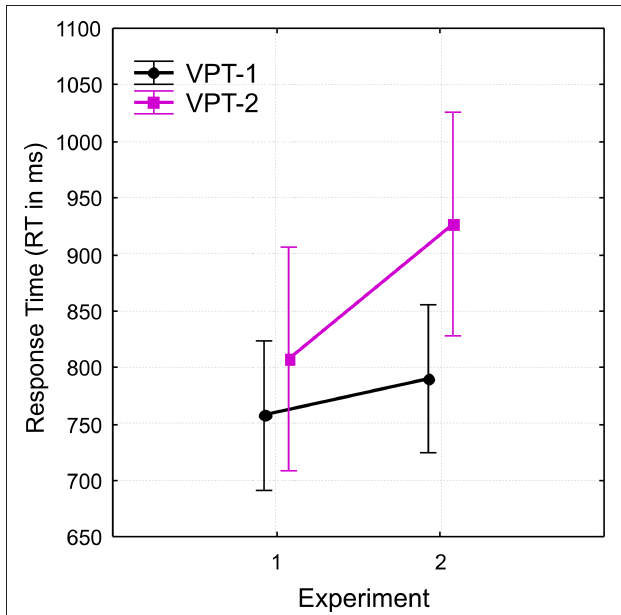
Figure 6 | Comparing the two experiments. Group mean response times (RT) for VPT-1 vs. VPT-2 and for each Experiment (1 vs. 2) reflecting the significant interaction between “experiment” and “task”. Vertical bars denote the standard error of mean. Further explanations in the